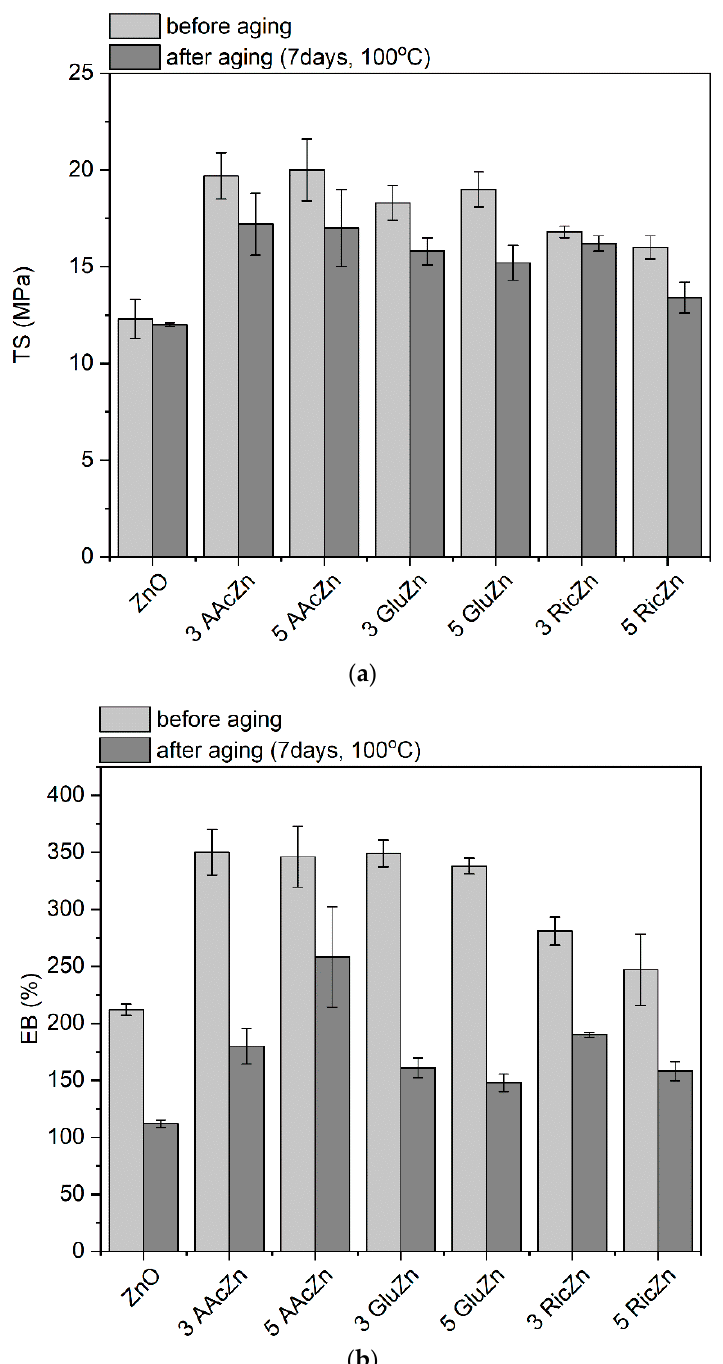
Figure 11. Effect of thermo-oxidative aging on the mechanical properties of SBR vulcanizates with varying activators: ( a ) tensile strenght ( b ) elongation at break.